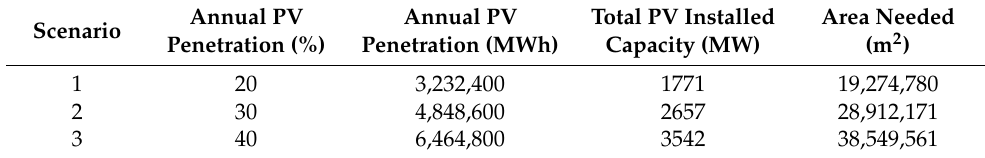
Table 14. Scenarios of PV penetration evaluated for all